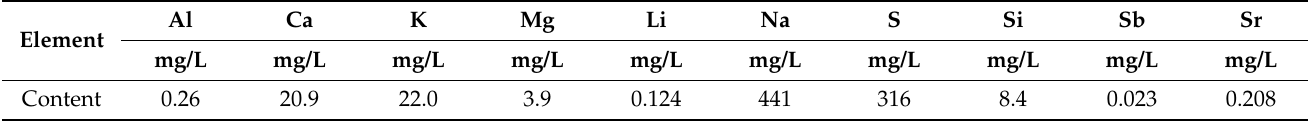
Table 3. Element content table of Baojinshan ore